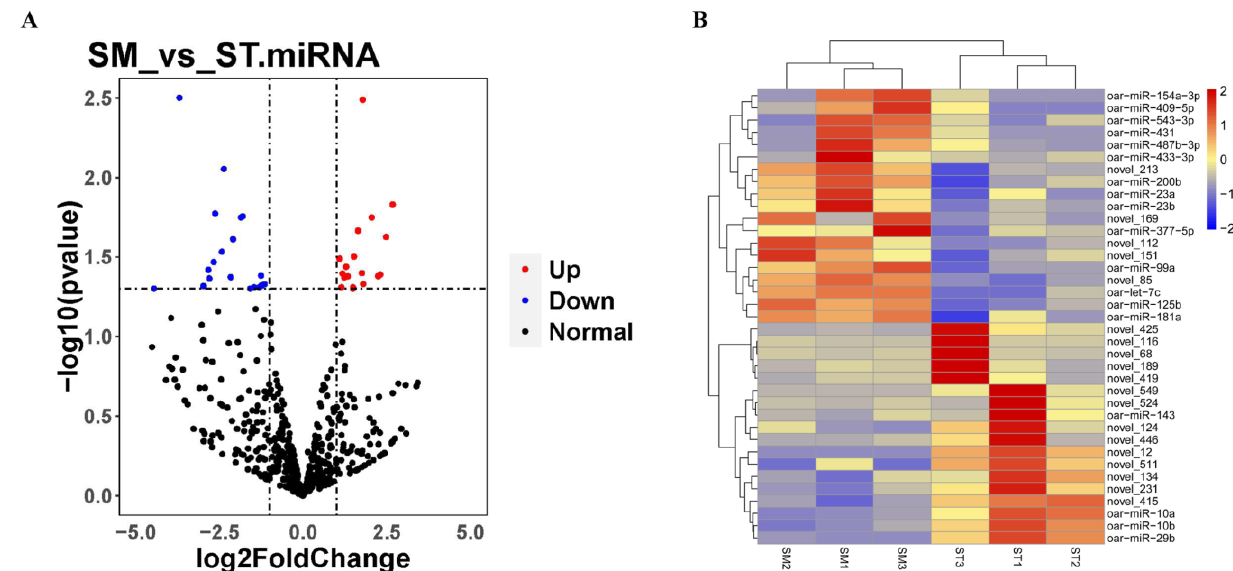
Figure 3. Significant difference analysis of miRNAs. ( A ) Volcano plot of identified miRNAs between SM vs. ST, where blue and red represent down-regulated and up-regulated, respectively. ( B ) Heat maps revealing the differentially expressed (DE) miRNA in hair follicle between SM vs. ST.